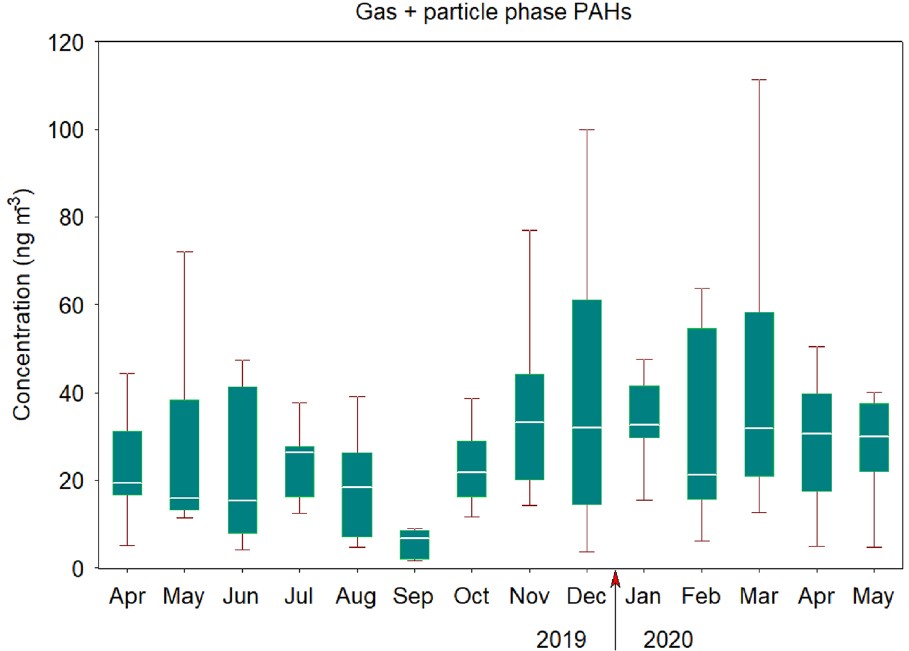
Figure 1. Boxplot of Σ 16 PAHs concentrations in the gas and particle phases during the 2019–2020 sampling period in Gdynia, Poland. The boxes represent the 25th and 75th quantiles, the black line inside represents the median value, and the bottom/top whiskers are the minimum and maximum values,